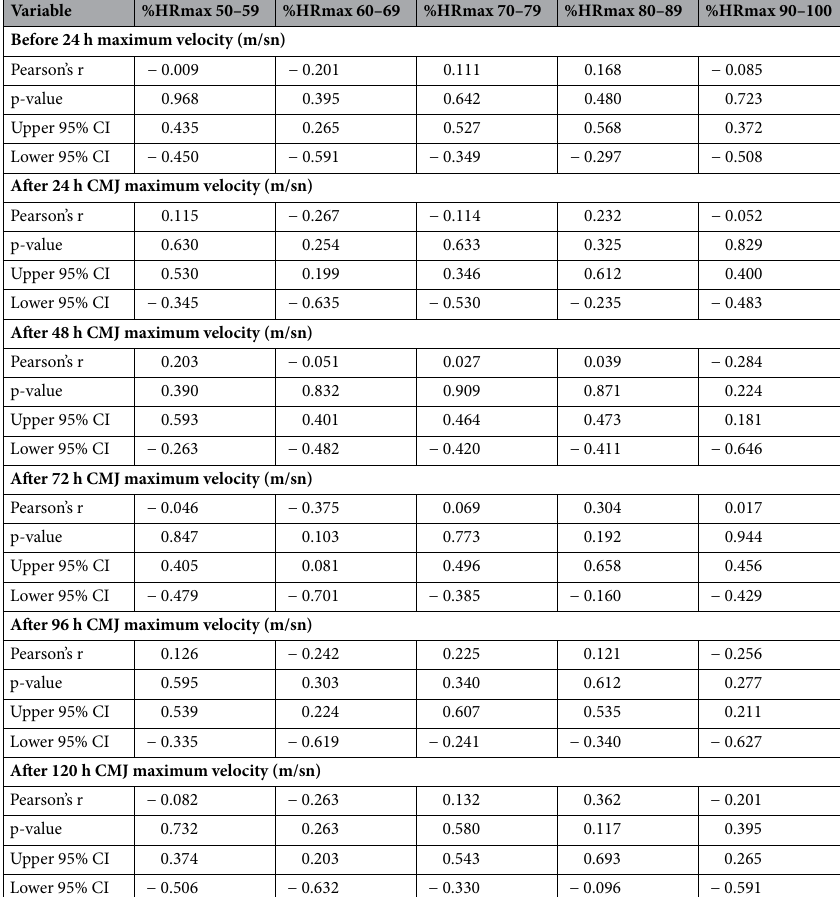
Table 6. Comparison of the match internal loads and CMJ maximum velocity